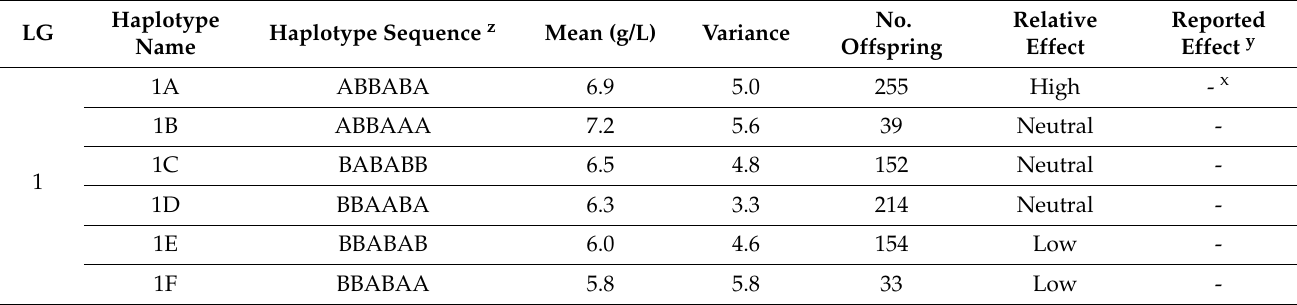
Table 2. Summary of QTL haplotype effects for the LG1, LG8, and LG16 TA QTLs. Across-year adjusted TA means for six families were